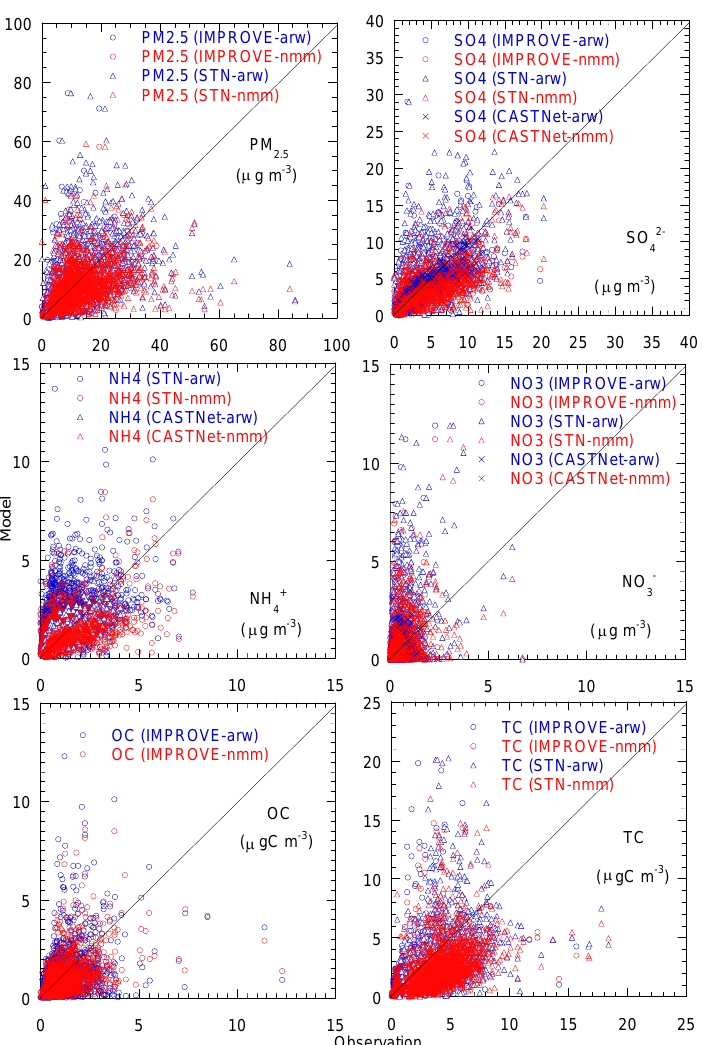
Figure 3a. Comparison of observed and modeled (ARW-CMAQ and NMM-CMAQ) Fig. 3a. Comparison of observed and modeled (ARW-CMAQ and NMM-CMAQ) PM 2 . 5 and its chemical composition at the IMPROVE, PM 2.5 and its chemical composition at the IMPROVE, STN and CASTNet sites during STN and CASTNet sites during the 2006 TexAQS/GoMACCS the 2006 TexAQS/GoMACCS period